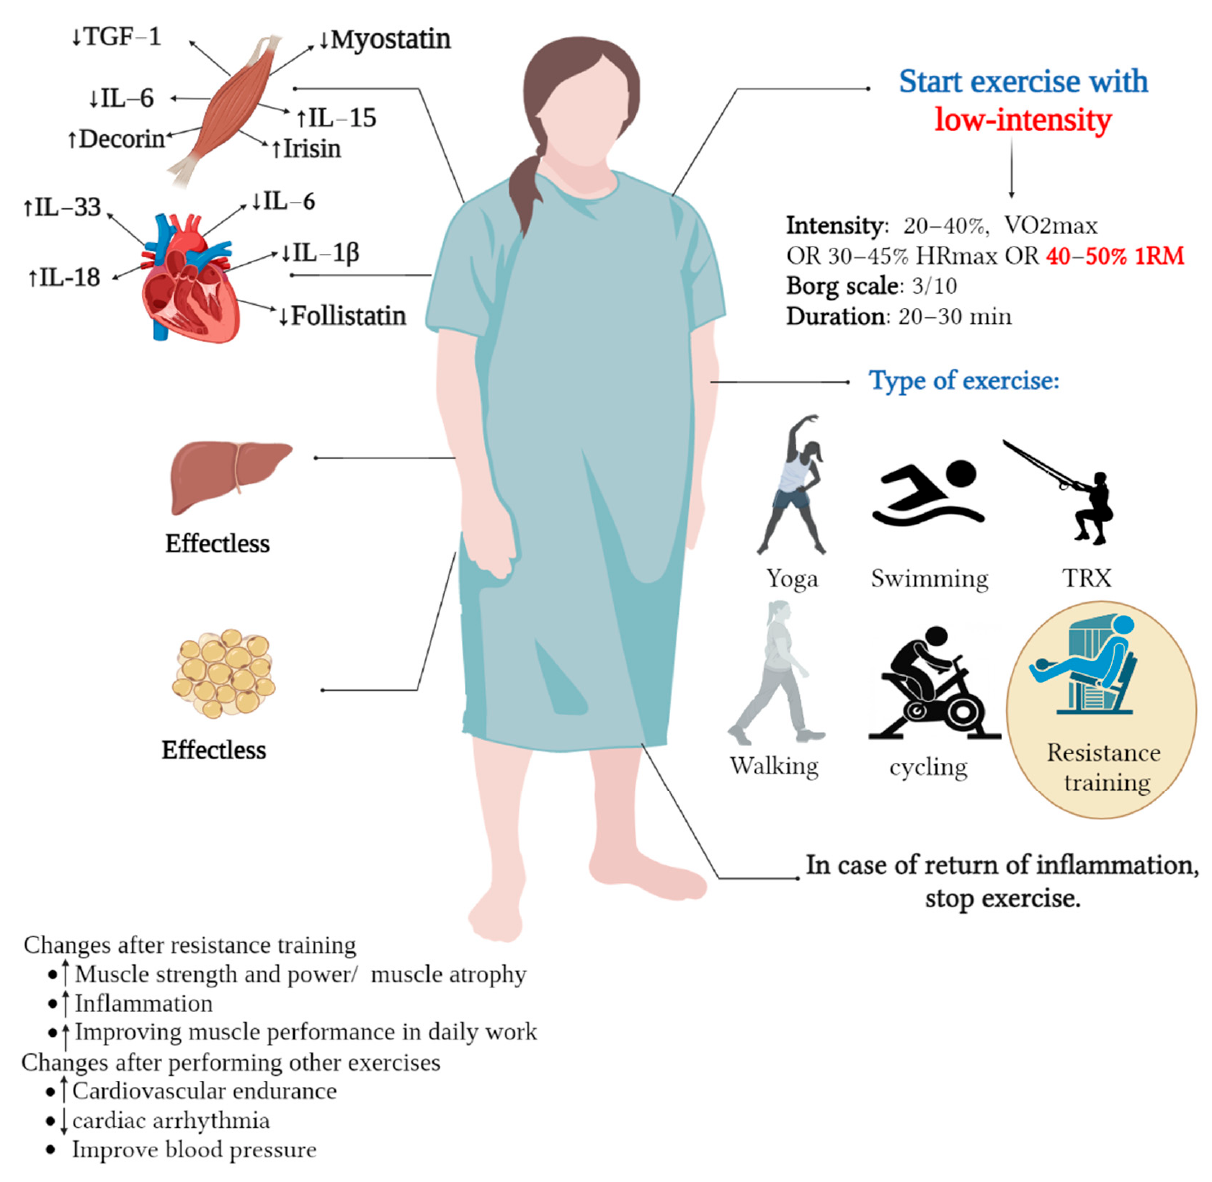
Figure 3. Effect of low-intensity exercise on exerkines in women with COVID-19 or discharged from hospital. TGF: transforming growth factor, IL: interleukin, RM: repetition maximum. Table 1. The effect of different types and intensities of physical exercise (low, moderate, and high) on the stimulation of exerkines .